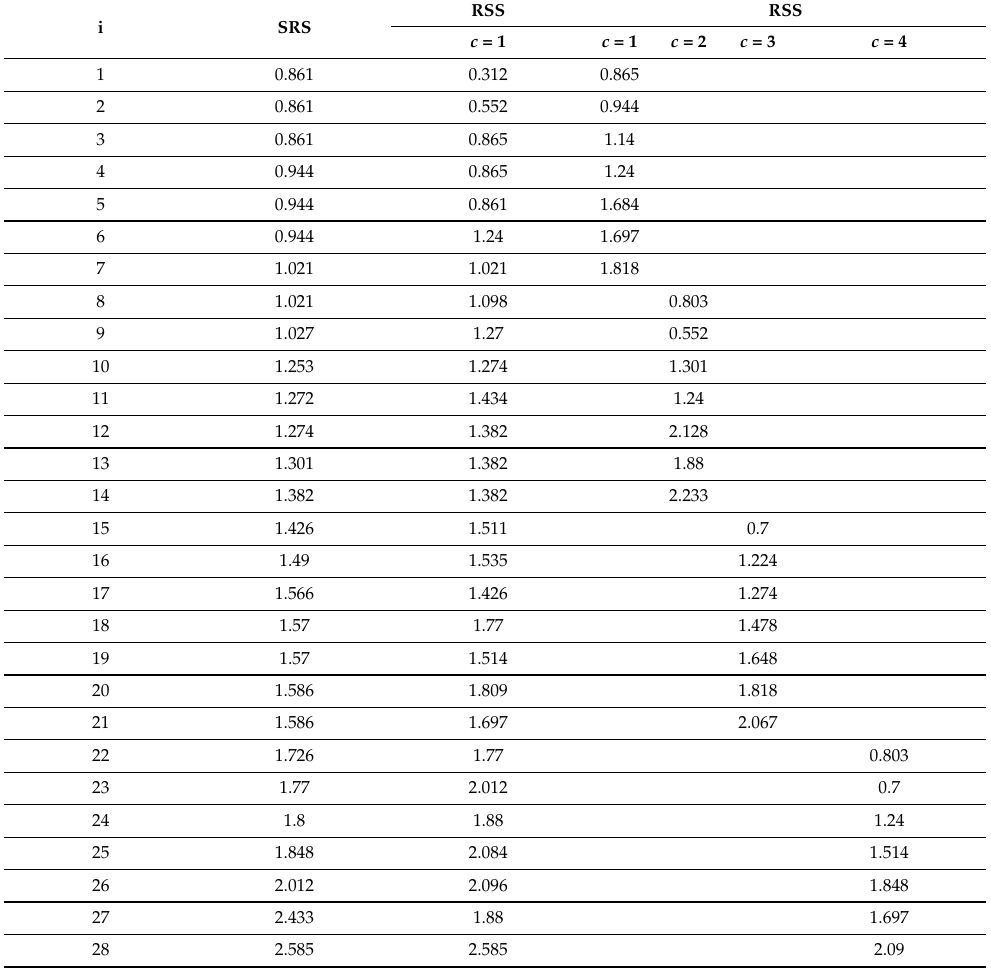
Table 17. SRS and RSS for the carbon fibre data.